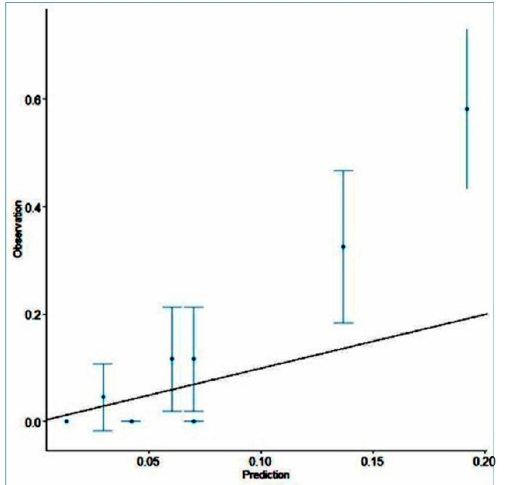
Figure 4. Calibration graph of the mortality prediction of the AFC/OCC score.